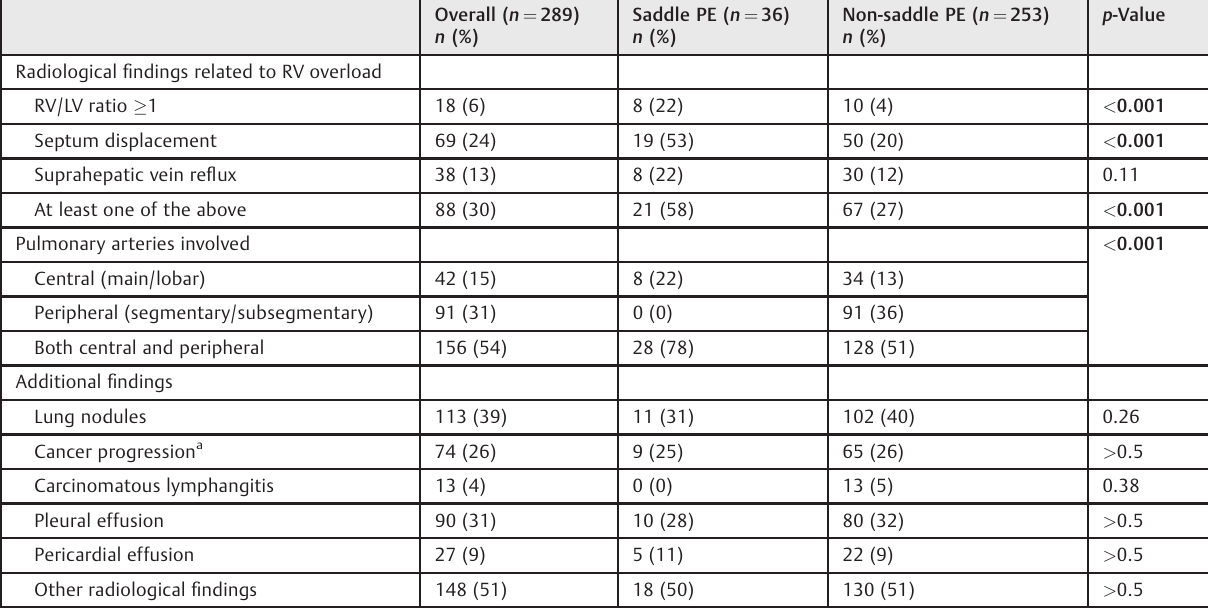
Table 3 Radiological fi ndings according to the presence of saddle versus non-saddle pulmonary embolism